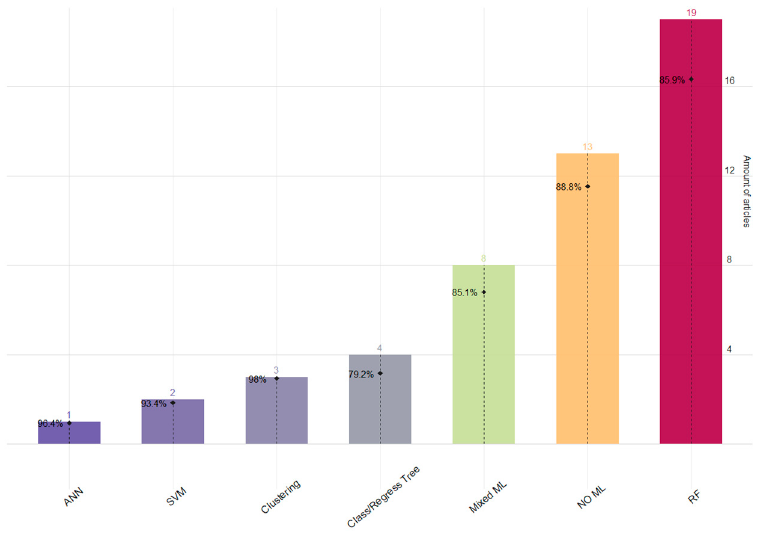
Figure 8. Distribution of the method used and average accuracy. The long-dash line indicates the accuracy scale from 0% to 100%; the dot marks the average accuracy (ANN = 96.4%, SVM = 93.4%, Clustering = 98%, Classification/Regression Tree = 79.2%, Mixed ML = 85.1%, NO ML = 88.8%, and RF = 85.9%).